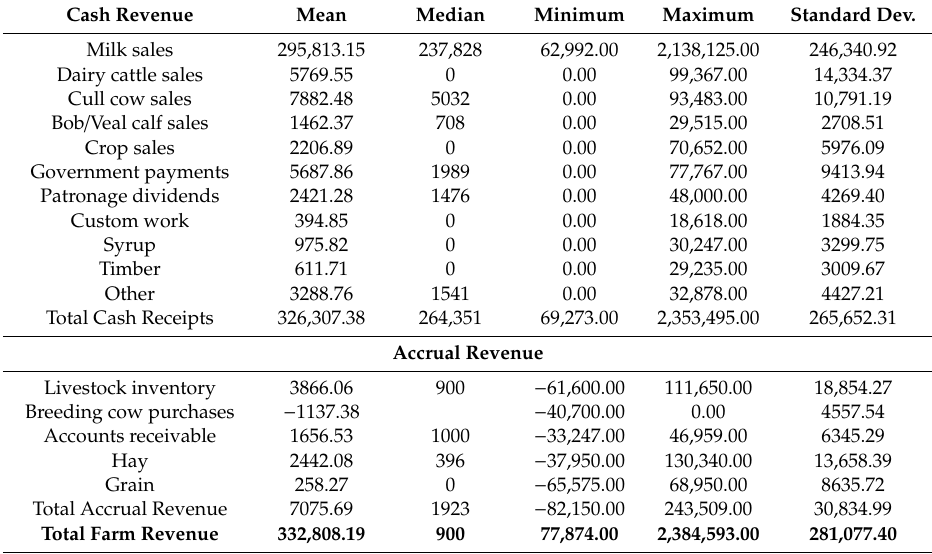
Table A1. Vermont Organic Dairy Income (USD) 2006–2016 (n = 392). Not adjusted for inflation